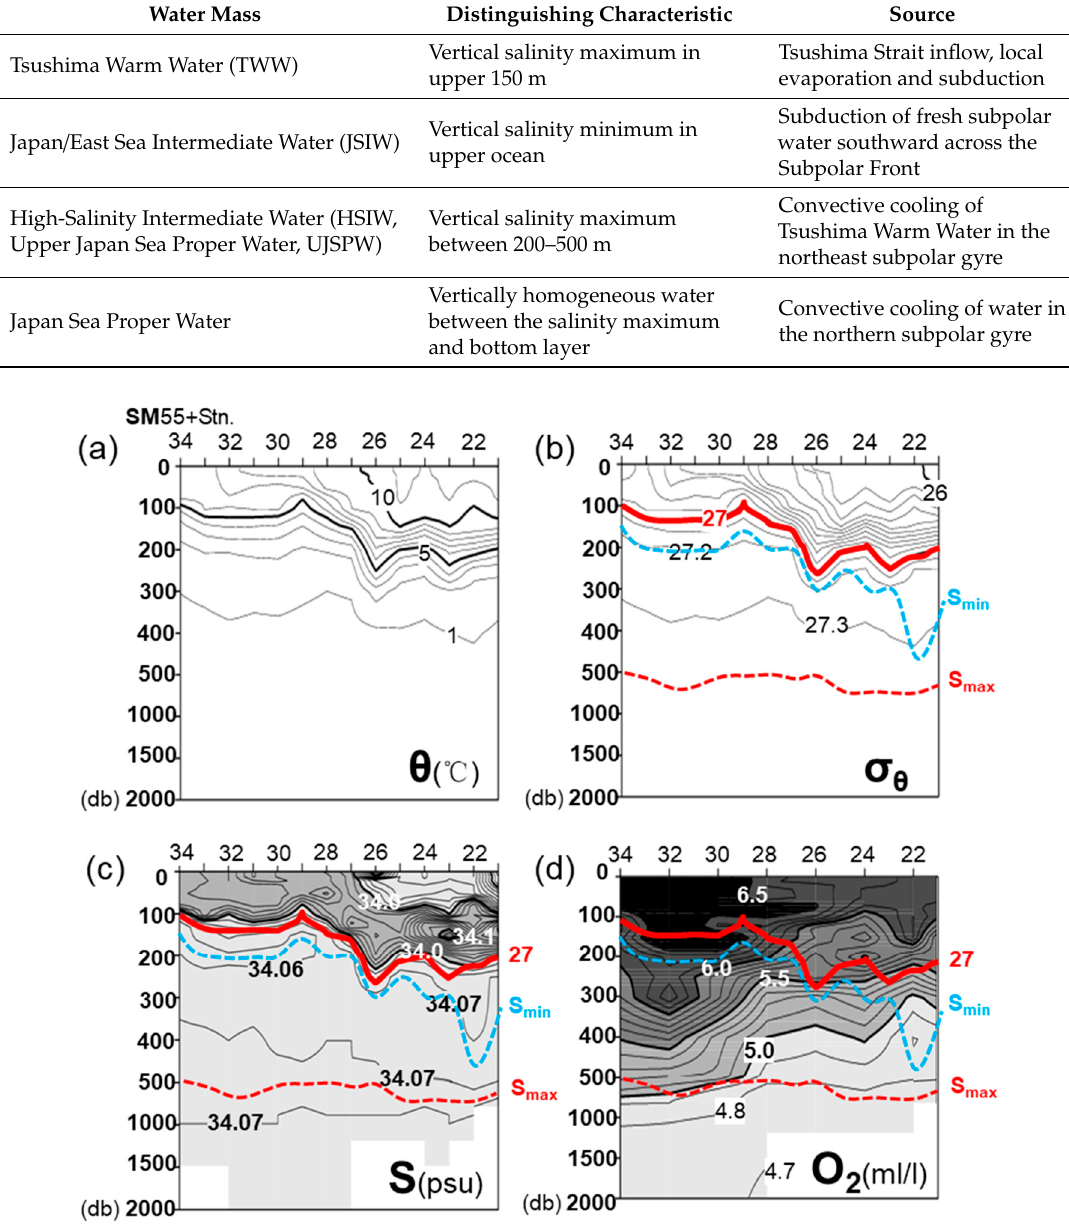
Figure 2. Vertical cross-sections of ( a ) potential temperature( θ ), ( b ) potential density ( σ θ ), ( c ) salinity (S), ( d ) dissolved oxygen (O 2 ) in the Japan Sea along line SM. Red solid line, red broken line and blue broken line indicate σ θ of 27.0, salinity maximum (S max ) and minimum (S min ).